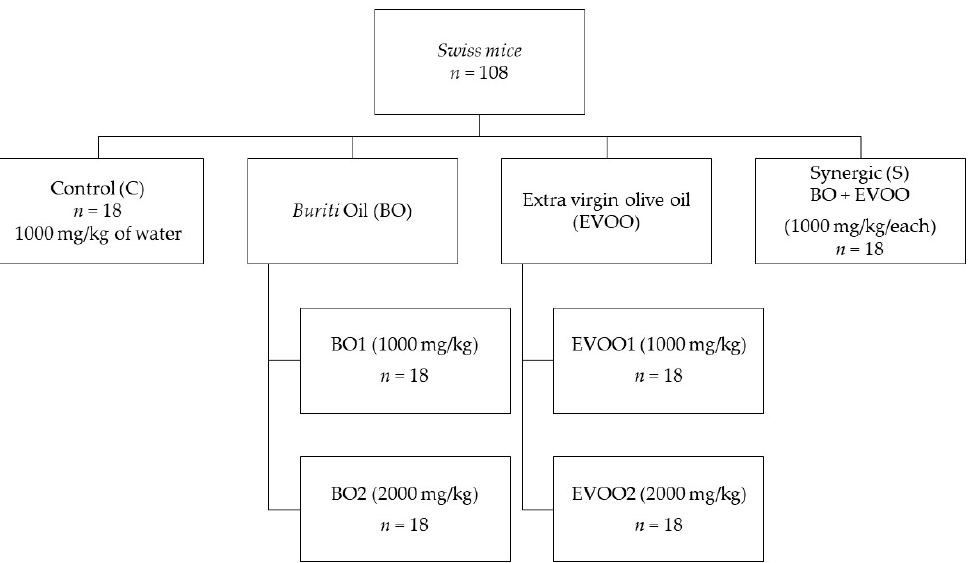
Figure 1. Intervention protocol for the supplementation with buriti oil. C, control group (without lipidic supplementation); EVOO1, extra virgin olive oil (1000 mg/kg); EVOO2, extra virgin olive oil (2000 mg/kg); BO1, buriti oil (1000 mg/kg); BO2, buriti oil (2000 mg/kg); Synergic, EVOO1 + BO1.